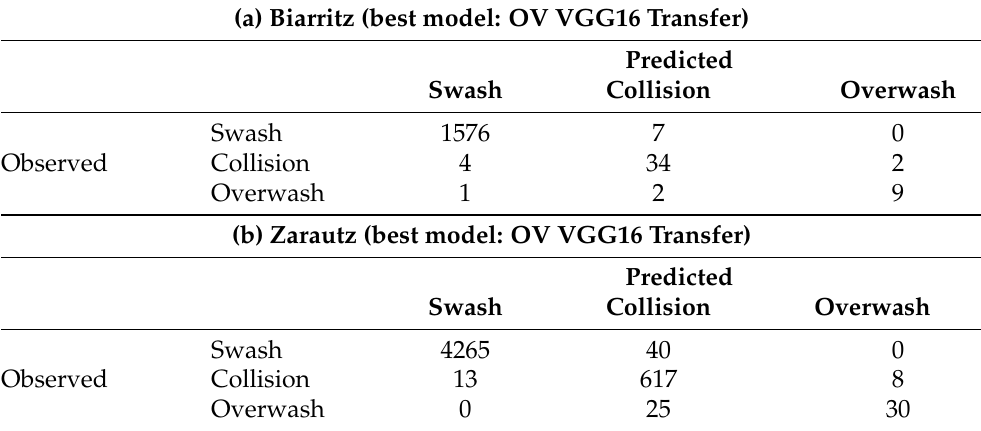
Table 2. Confusion matrices obtained by the best models for both